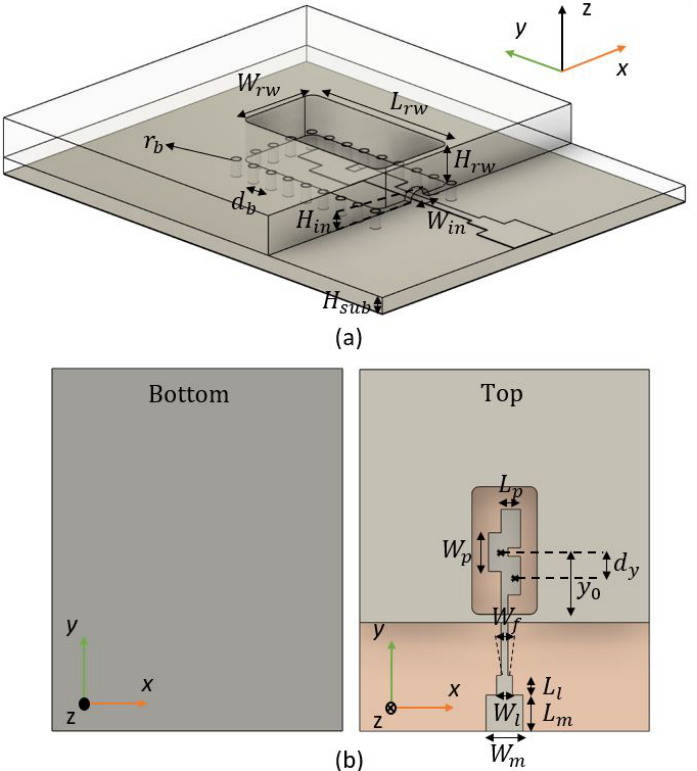
Figure 1. Artist view of the Top-Side transition for ( a ) isometric view and ( b ) top and bottom